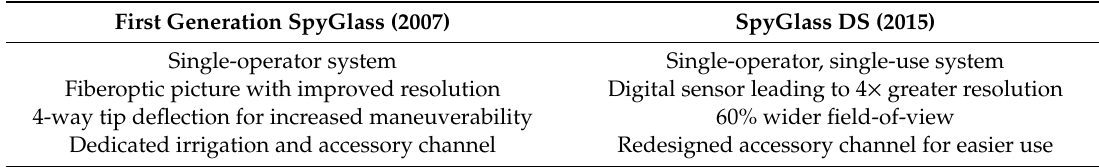
Table 1. The progression of SpyGlass single operator cholangioscopy.